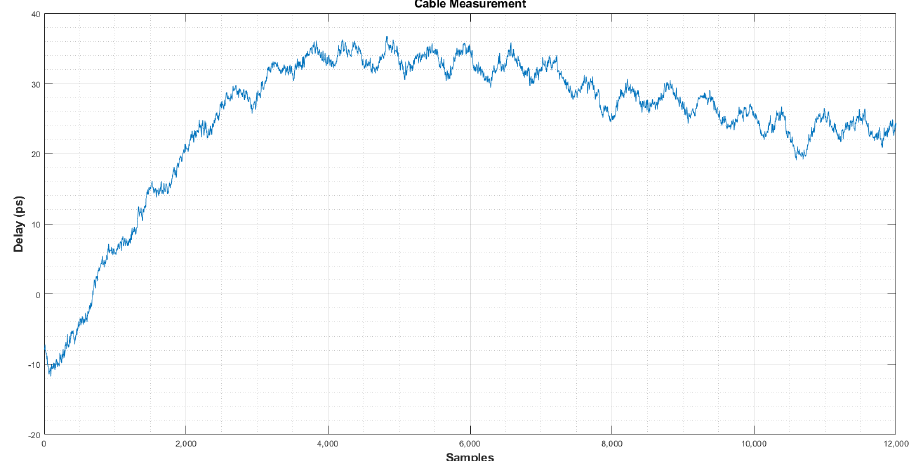
Figure 16. Stability of the system with the radio telescope in stow